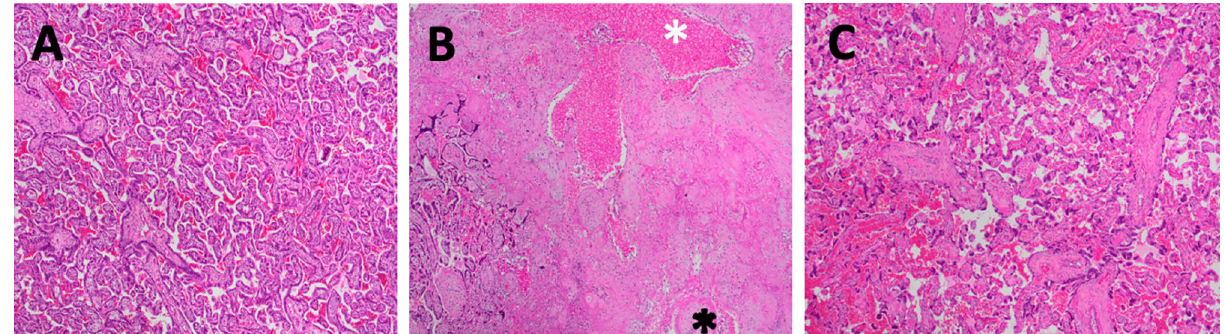
Figure 4. Placental microinfarctions associated with prenatal THC exposure. ( A ) Representative control H&E-stained placental section at gestational day 155 with normal villous and stroma, ( B ) acute (white asterix) and remote (black asterix) villous infarctions from a THC-exposed placenta, ( C ) markedly increased syncytial knotting from a THC-exposed placenta. Magnification is